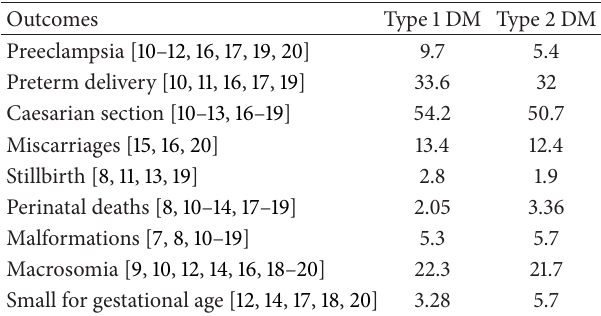
Table 3: Detailed data about obstetric, fetal, and neonatal outcomes by type of diabetes. Results shown as mean percentage